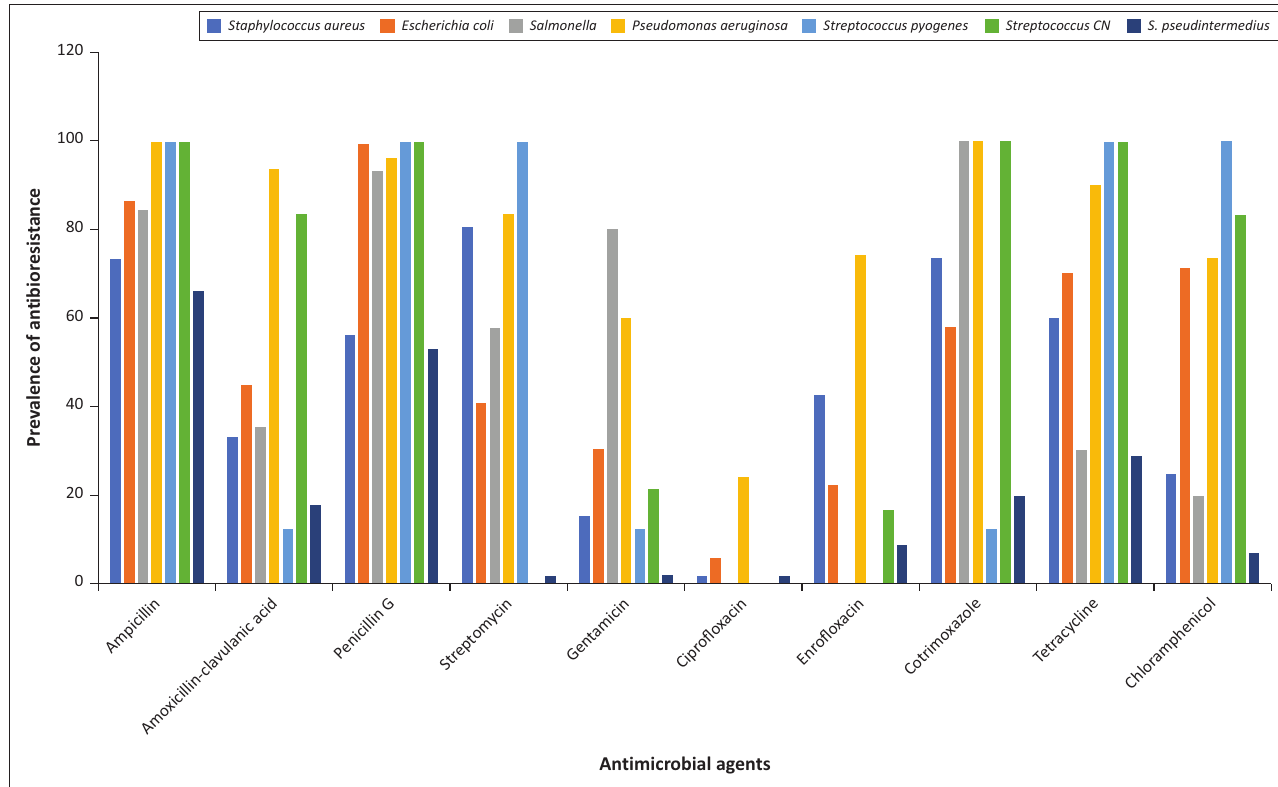
FIGURE 3: Antibiotic resistance of strains from sampled animals.